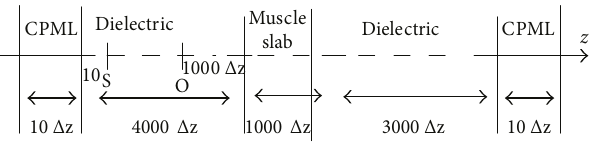
Figure 3: Structure of simulation domain (where S and O are, resp., the source point and observation